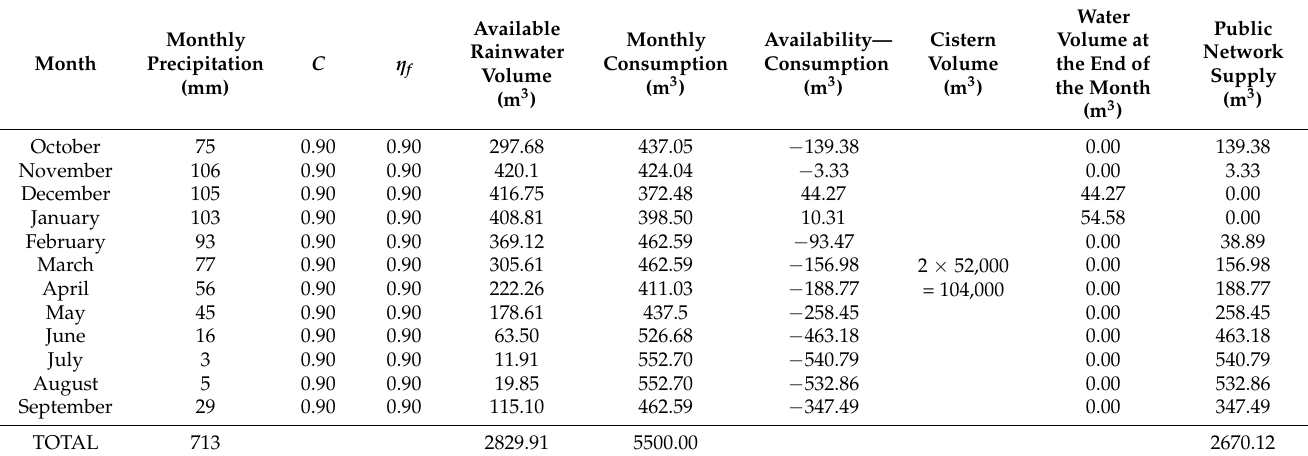
Table 3. Rainwater harvesting system cistern